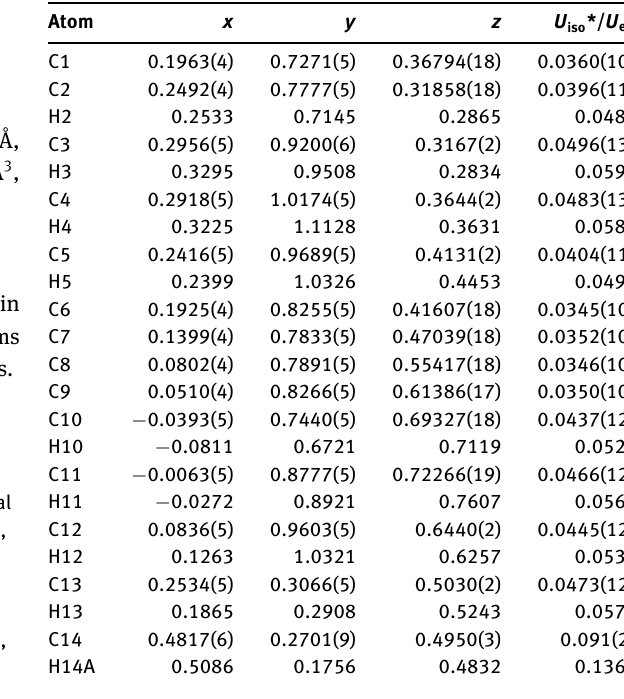
Table 2: Fractional atomic coordinates and isotropic or equivalent isotropic displacement parameters (Å 2